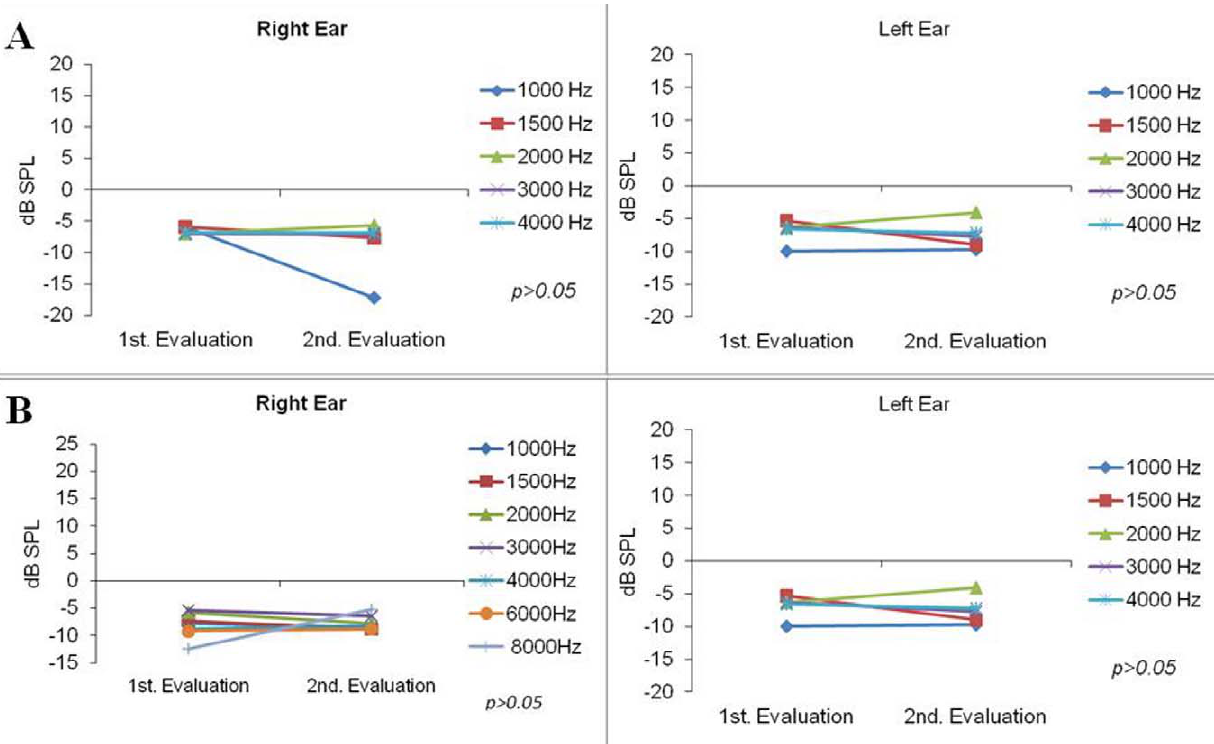
Figure 1. Otoacoustic emissions. (A) Transient otoacoustic emissions values were obtained in both ears at the following frequencies: 1000, 1500, 2000 and 4000 Hz in the first and second evaluations (after using a hearing aid in the right ear). (B) Distortion product otoacoustic emissions values were obtained in both ears at the following frequencies: 1000, 1500, 2000, 3000, 4000, 6000 and 8000 Hz in the first and second evaluations. No significant differences were found (p . 0.05).